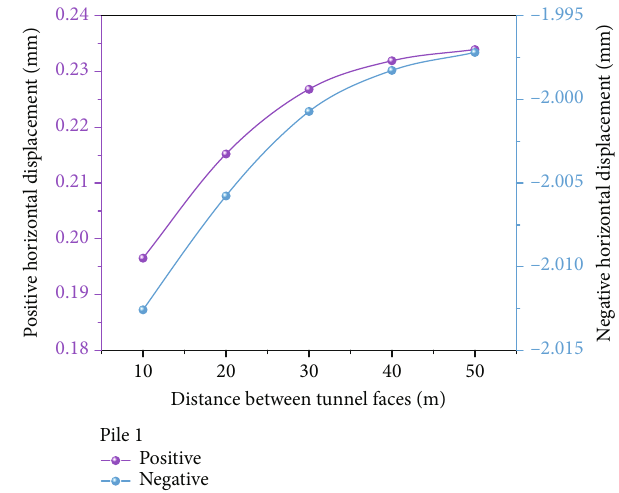
Figure 17: Maximum horizontal displacements of Pile 1 on completion of twin tunneling at di ff erent tunnel face-to-face